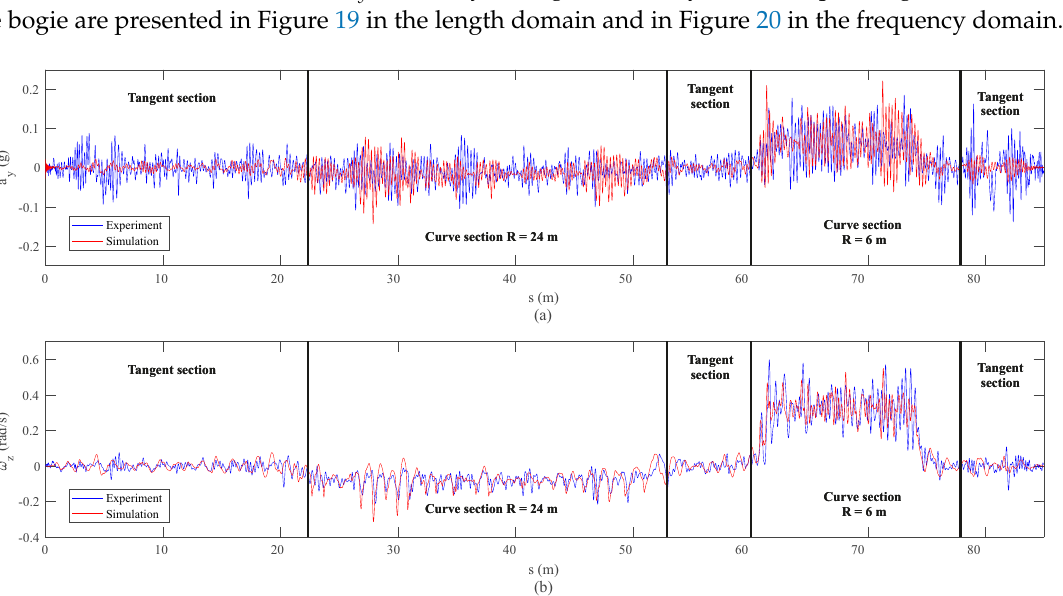
Figure 19. Lateral acceleration ( a ) and yaw angular velocity ( b ) data from inertial sensors on the bogie frame.